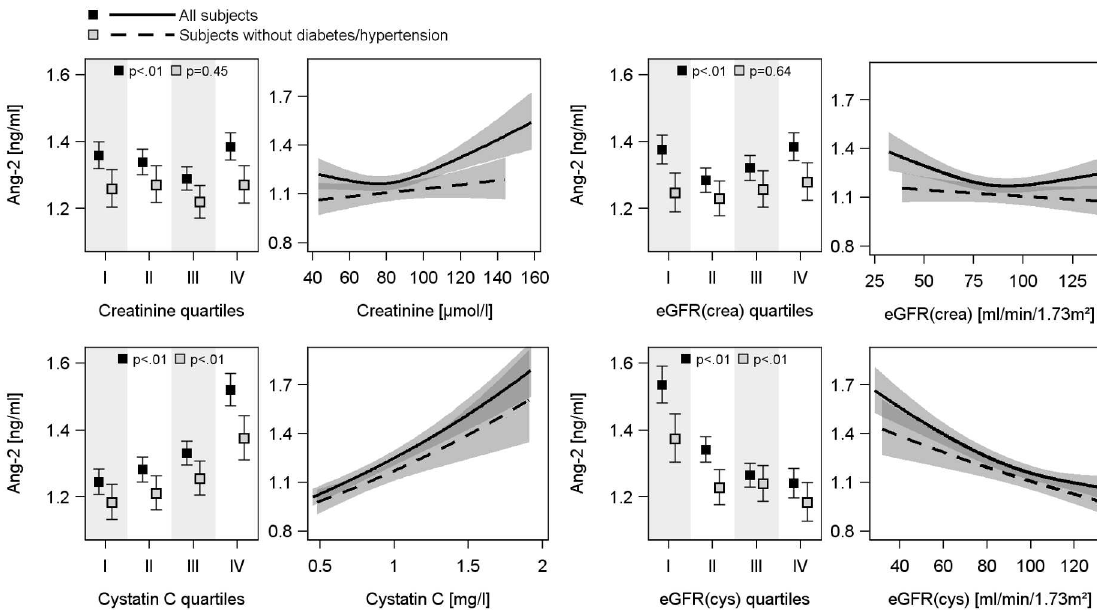
Fig 2. Associations between serum creatinine concentration, creatinine-based estimated glomerular filtration rate [eGFR(crea)], serum cystatin C concentration or cystatin C-based eGFR [eGFR(cys)] and serum angiopoietin-2 (Ang-2) concentration in the SHIP-1 population. For each exposureleft side: Estimated mean serum Ang-2 with 95% confidence intervals(CI) by sex-specific quartilesof exposure calculatedby analysisof variance adjustedfor age, sex and waist circumference. Right side: linear regressionline with 95% CI (grey shaded area). Linearregressionmodels with restricted cubic splineswere adjustedfor age, sex, waist circumference, smoking, total cholesterol, systolic and diastolic bloodpressure and additionallyin the whole populationfor diabetes mellitus type 2 and use of antihypertensive